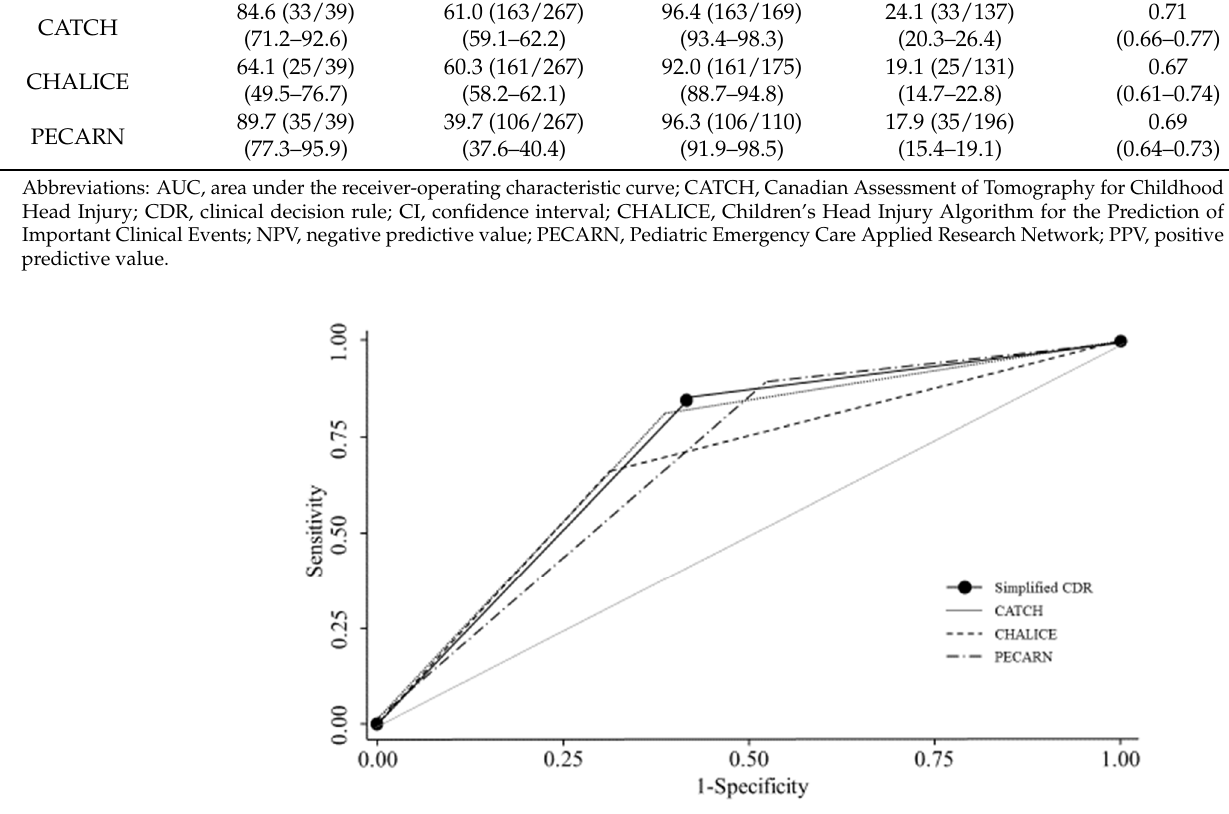
Figure 2. Comparison of our simplified clinical decision rule with CATCH, CHALICE, and PECARN. The novel simplified CDR (AUC 0.72; 95% CI: 0.67–0.77), CATCH (AUC 0.71; 95% CI: 0.66–0.77), CHALICE (AUC 0.67; 95% CI: 0.61–0.74), and PECARN (AUC 0.69; 95% CI: 0.64–0.73) for clinically important TBI. Abbreviations: CATCH, Canadian Assessment of